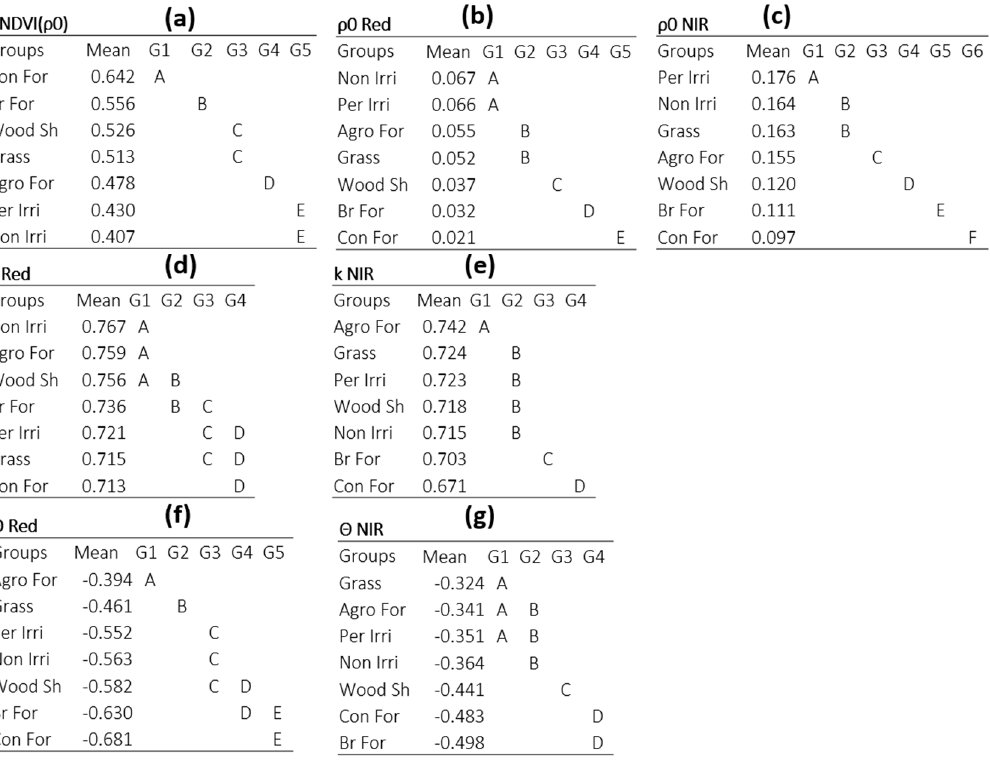
Figure 5. Results from the pairwise Tukey post hoc tests to observe if there were statistically parameter-band mean value differences (p < 0.01) between pairs of CLC categories. Non Irri is the abbreviation of the non-irrigated arable land; Non Irri the permanently irrigated land; Agro For the agro-forestry areas; Br For the broad-leaved forest; Con For the coniferous forest; Grass the natural grasslands; Wood Sh the transitional woodland-shrub. ( a ) NDVI post hoc test ( ρ 0); ( b ) ρ 0 red post hoc test; ( c ) ρ 0 NIR post hoc test; ( d ) k red post hoc test; ( e ) k NIR post hoc test; ( f ) Θ red post hoc test; and ( g ) Θ red post hoc test.